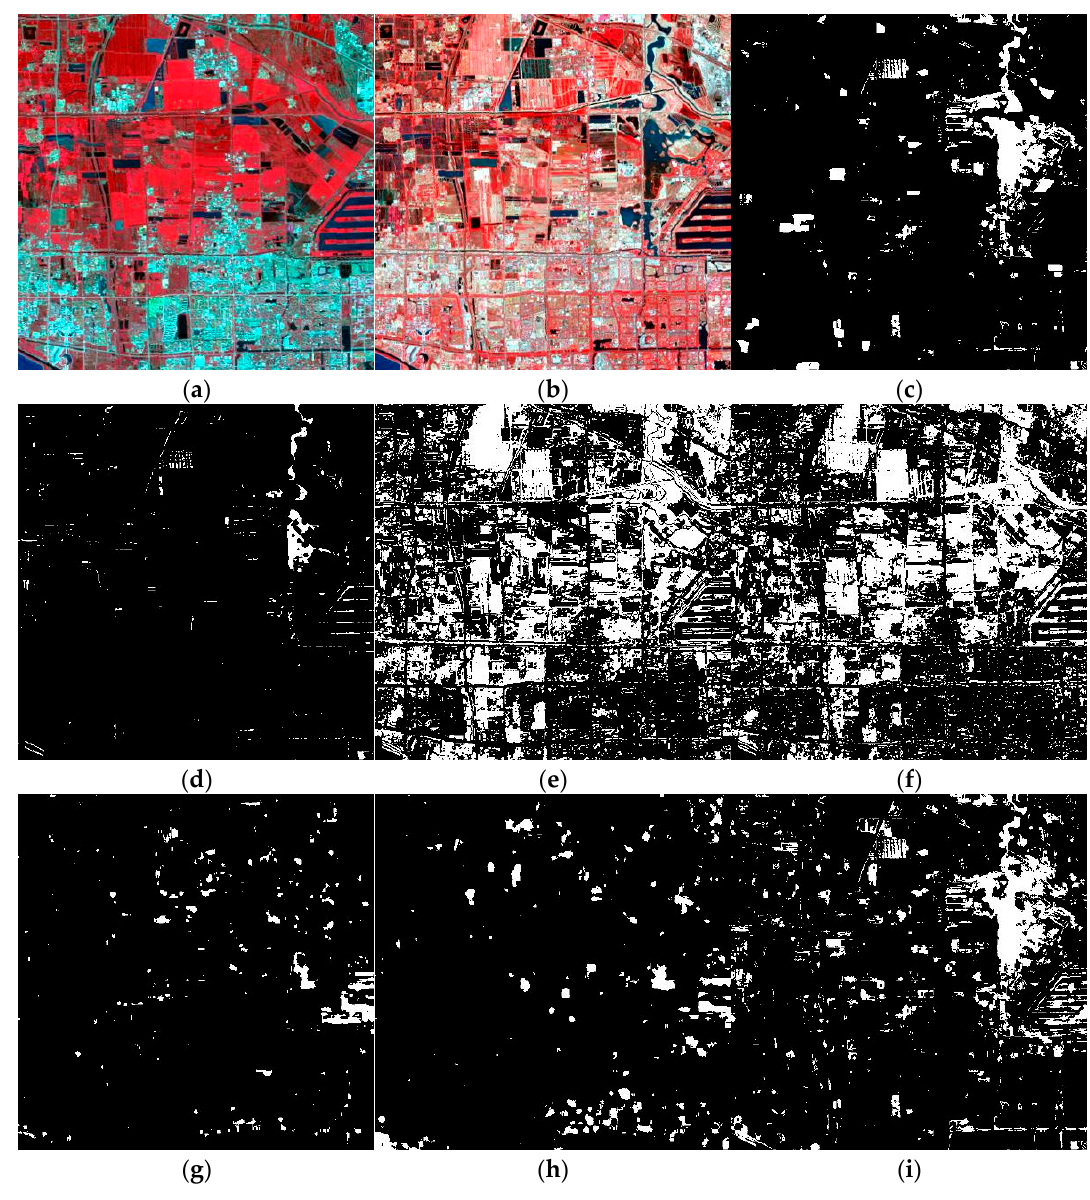
Figure 5. The change/no-change subareas (change is white). ( a ) TM image, ( b ) OLI image, ( c ) ground truth image. The results of ( d ) IR, ( e ) CVA, ( f ) SGD, ( g ) NDVI-GD, ( h ) Dcanb, ( i ) MSP.